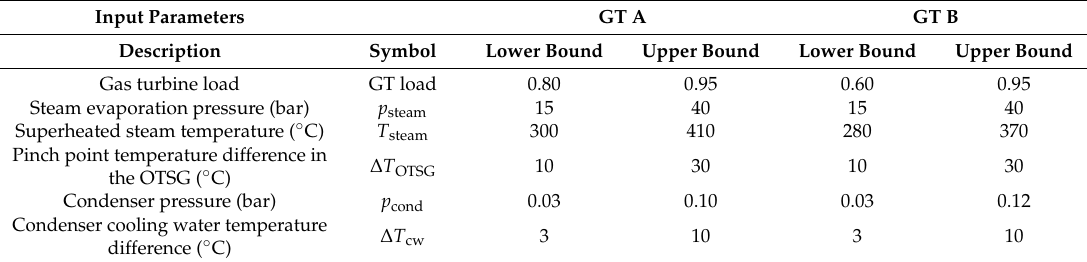
Table 2. List of the independent variables of the Kriging model, with the lower and upper bounds considered. The same bounds apply for the optimisation problem (OTSG: once-through heat recovery steam generator; GT: gas